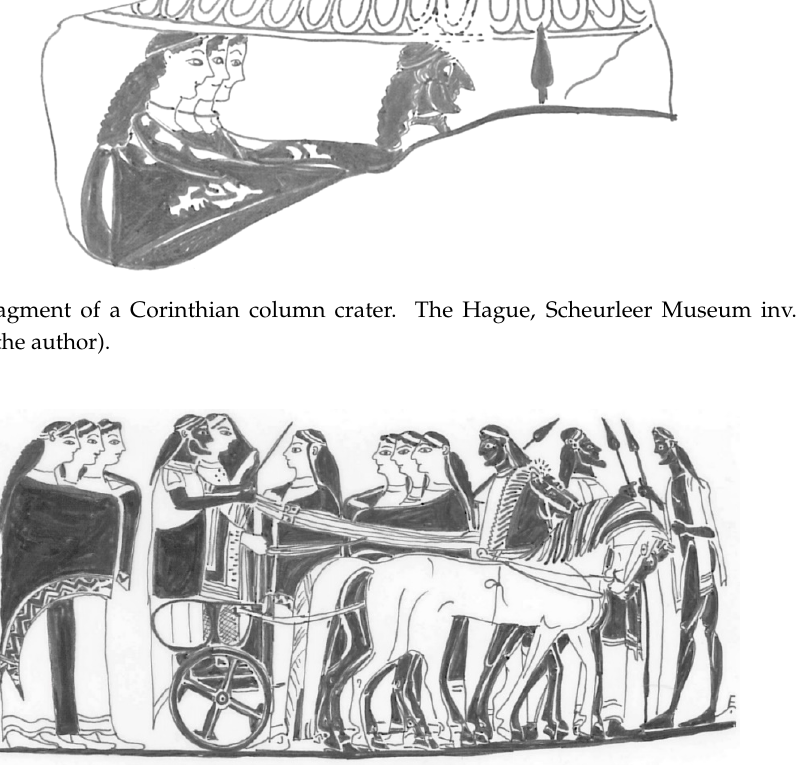
Figure 2. Corinthian Column Crater. Vatican, Museo Gregoriano Etrusco 126. Drawing by the